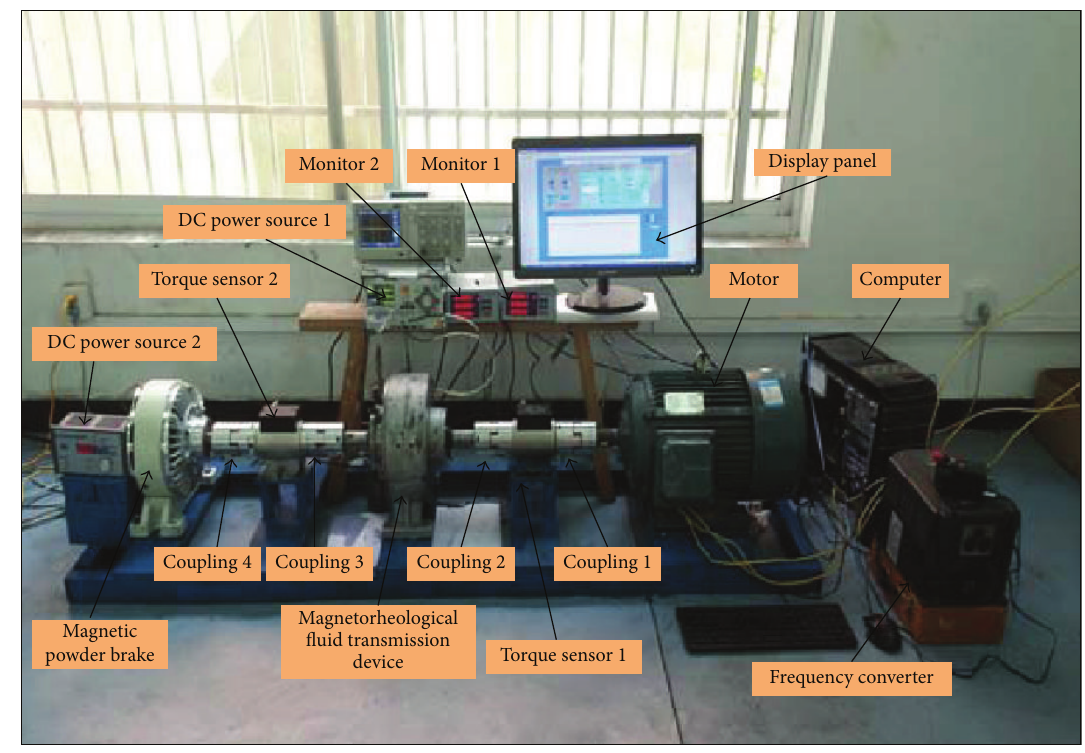
Figure 1: MRF test-bed.